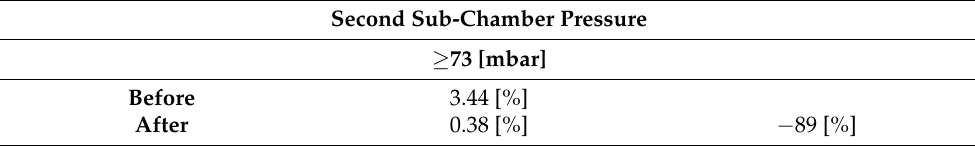
Table 13. Grate cooler APC system: KPI evaluation (second sub-chamber pressure